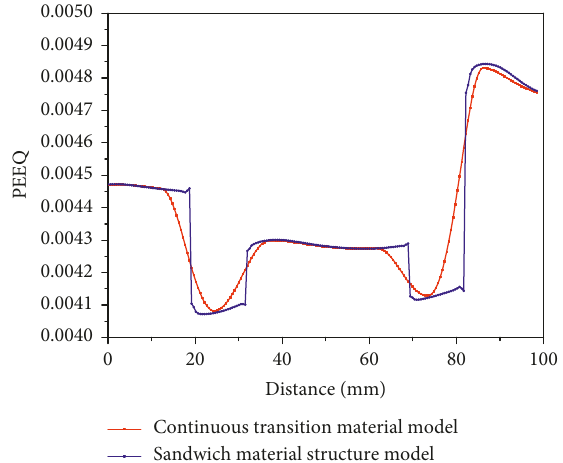
Figure 6: X -direction equivalent plastic strain curve of welding joint.